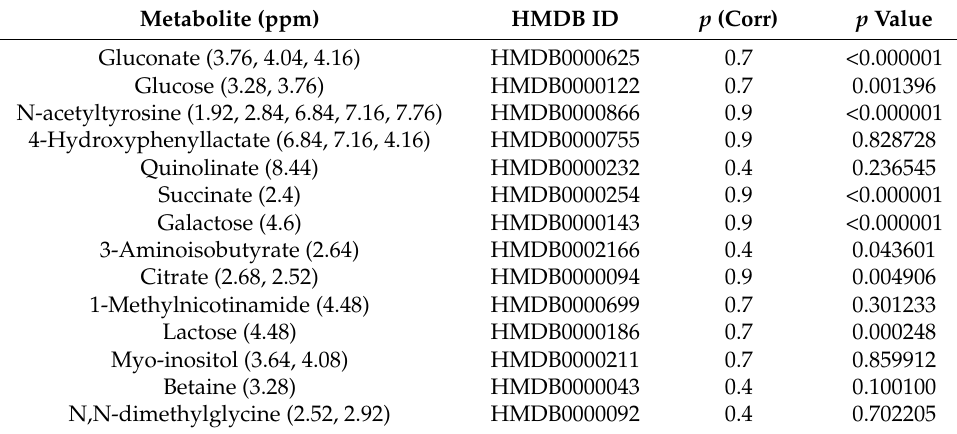
Table 2. Metabolites and non-assigned signals in the studied preterm newborns associated with NT with VIP values > 1.5. The p (corr) is the absolute value of the correlation loading in the S-line plot. The p values refer to the two-group independent samples comparison t test between the PN and EN groups.